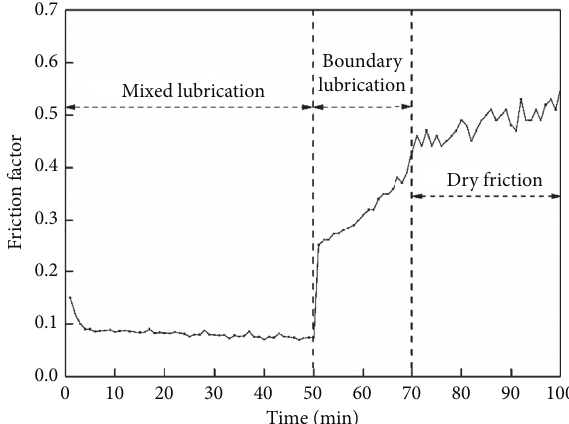
Figure 3: Temporal variation of friction factor in different lu- brication